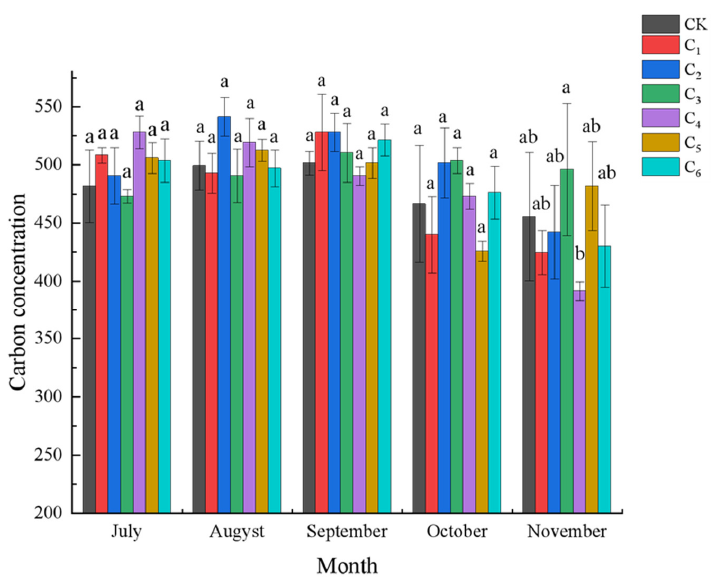
Figure 2. The carbon concentration in the roots of S. sebiferum container seedlings with different biochar treatments. Lowercase letters represent significance at 0.05 level and the same letter indicates no significant difference in full text.